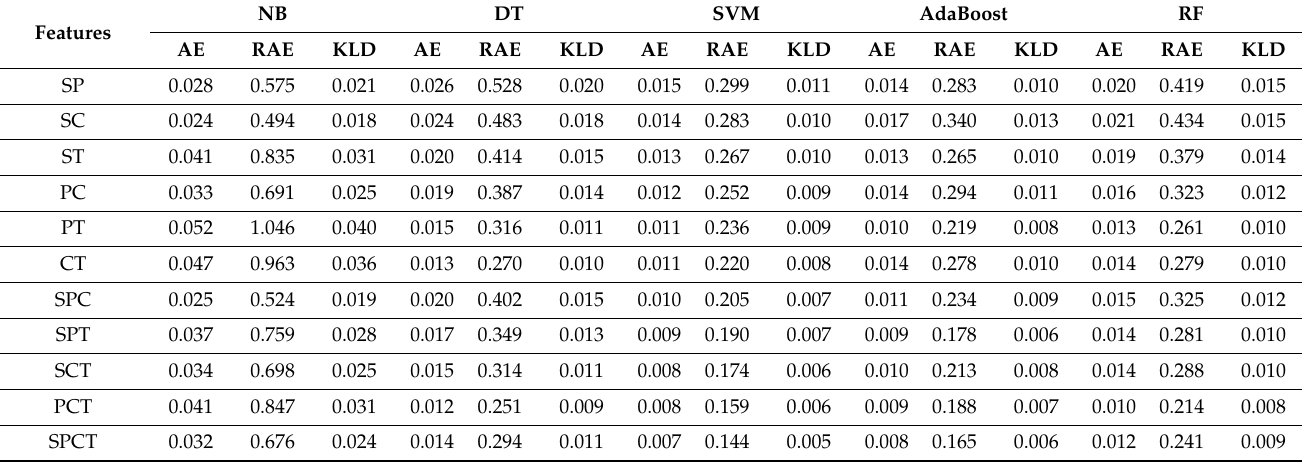
Table 8. Comparison of feature sets combination using ML classifiers on